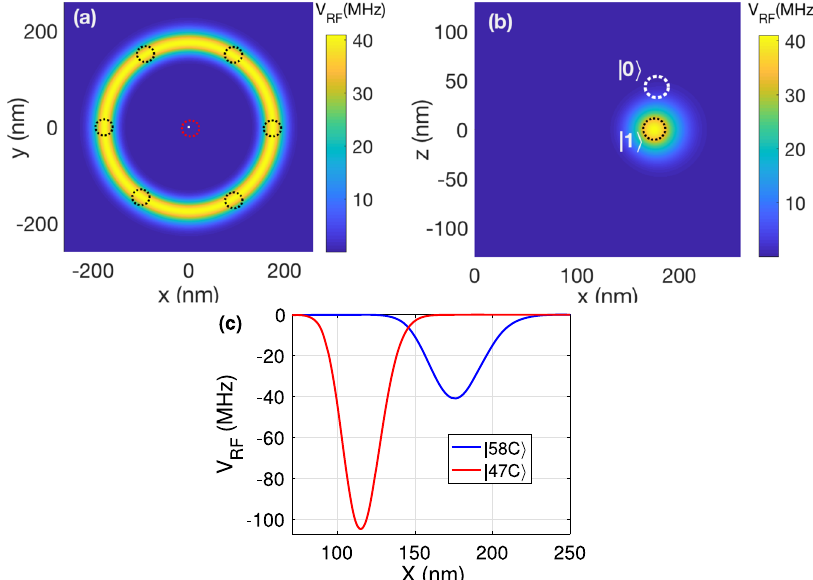
Fig. 6 Rydberg-Fermi interaction with circular states. Exciting 58 C j i , cross-sections of the interaction are plotted along a xy and b xz . The white and black circles depict the con fi ning area of the 0 j i and 1 j i qubit states of the plaquette lattice sites, while the Rb + core is at the origin. c The minimal overlap of the interaction pro fi le of 47 C j i and 58 C j i could be used for laser switching of the circular Rydberg-Fermi interaction, see the text.